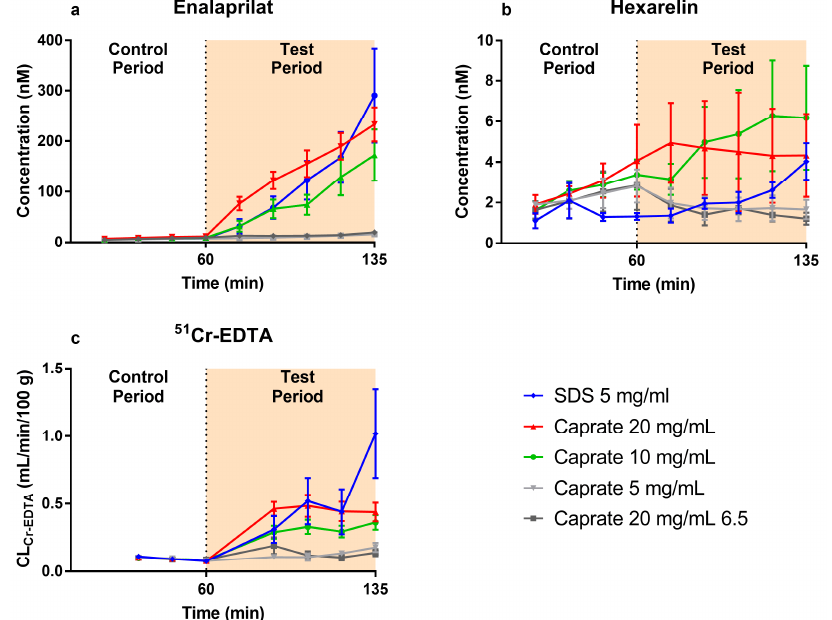
Figure 3. The mean (±SEM) plasma concentration–time profiles ( n = 5/6) of ( a ) enalaprilat and ( b ) hexarelin and ( c ) the blood-to-lumen clearance of 51 Cr-EDTA ( CL Cr-EDTA ), following the intestinal perfusions of a control solution for 60 min, followed by a 75-min perfusion of any of five test formulations containing a permeation enhancer: The control solution and all test formulations contained both 100 µM enalaprilat and 90 µM hexarelin. The perfusate pH was 7.4, and the permeation enhancers were sodium dodecyl sulfate (SDS) at 5 mg/mL and caprate at 5, 10, and 20 mg/mL. Caprate at 20 mg/mL was also tested at pH 6.5, where its solubility was 2 mg/mL instead of 5 mg/mL at pH 7.4.